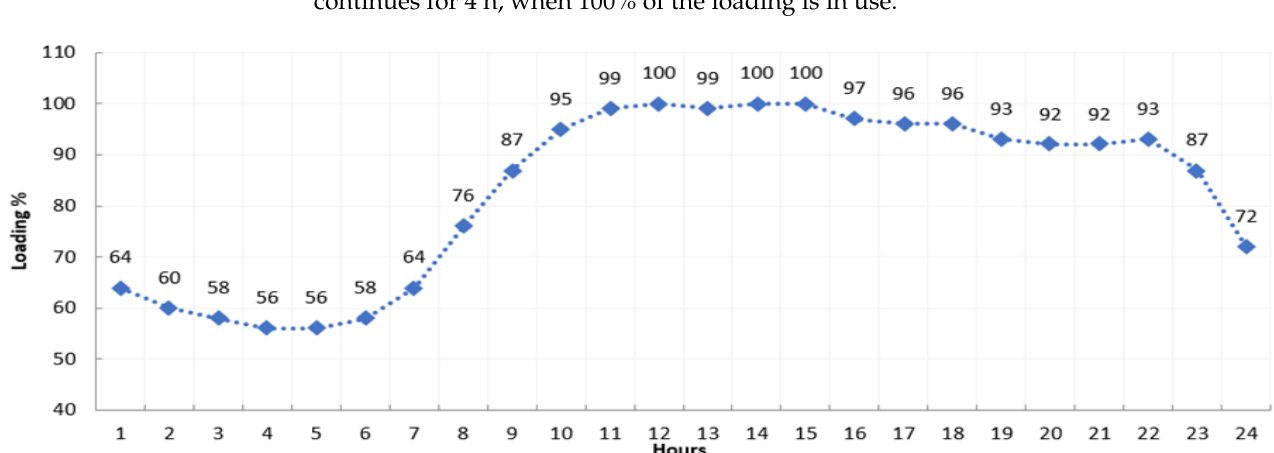
Figure 4. Hourly loading profile in percentage of the nominal condition [41].